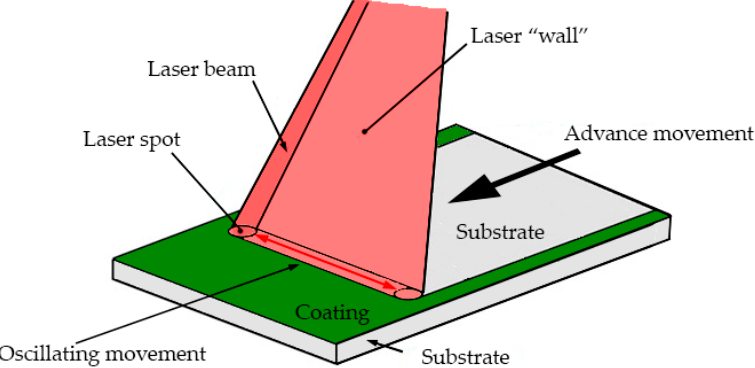
Figure 3. Laser working movements during coating removal process.